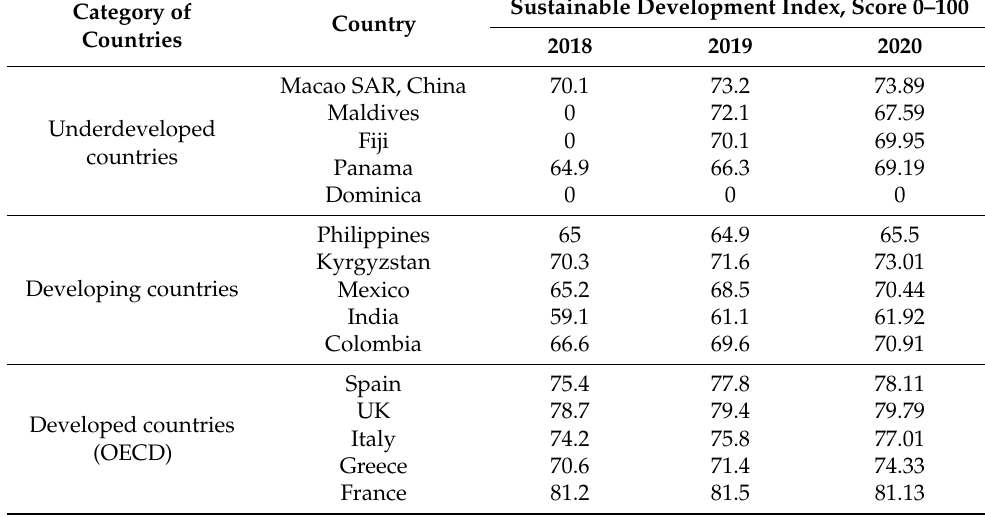
Table 4. Statistics on sustainable development in the distinguished categories of countries in